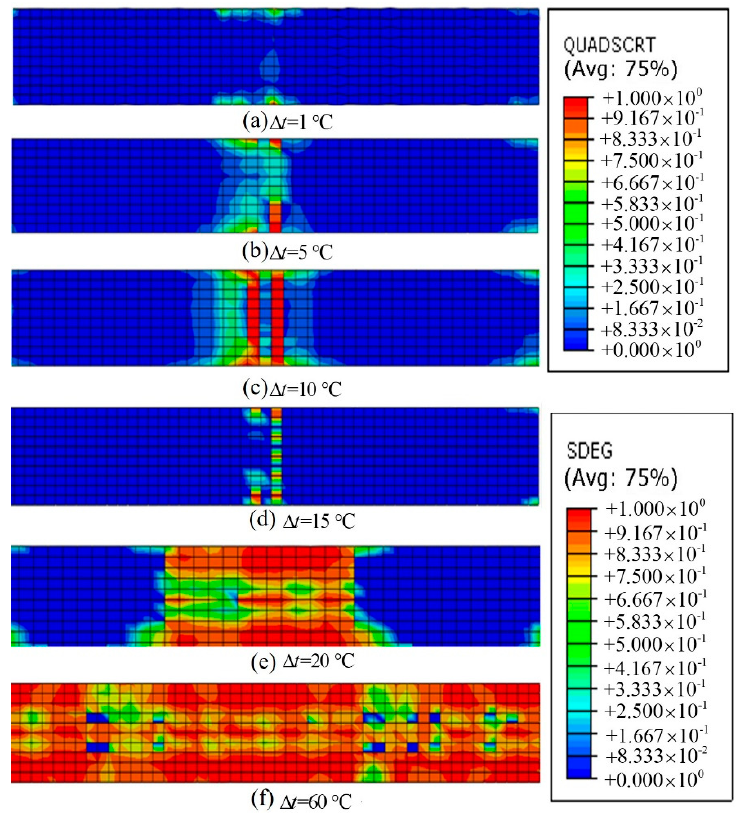
Figure 7. Interface damage evolution process under uniform temperature load.